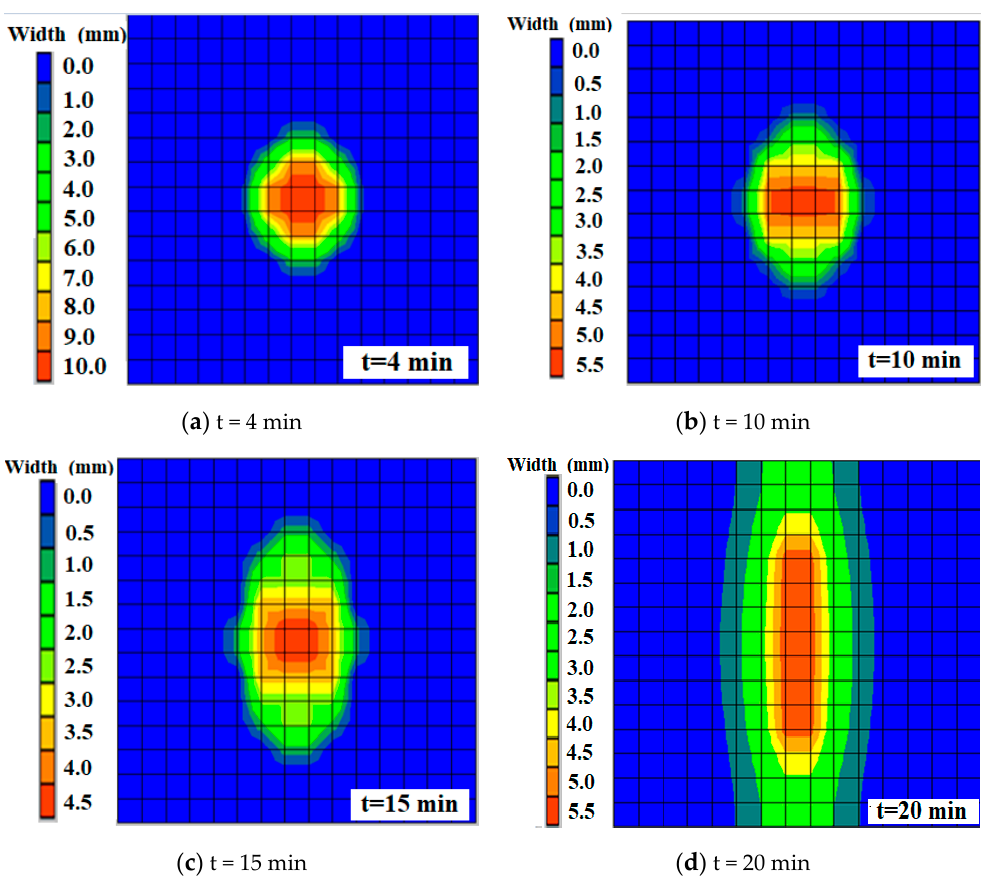
Figure 15. Hydraulic fracture apertures at t = 4 min ( a ), 10 min ( b ), 15 min ( c ) and 20 min ( d ) under 5 mL/min.